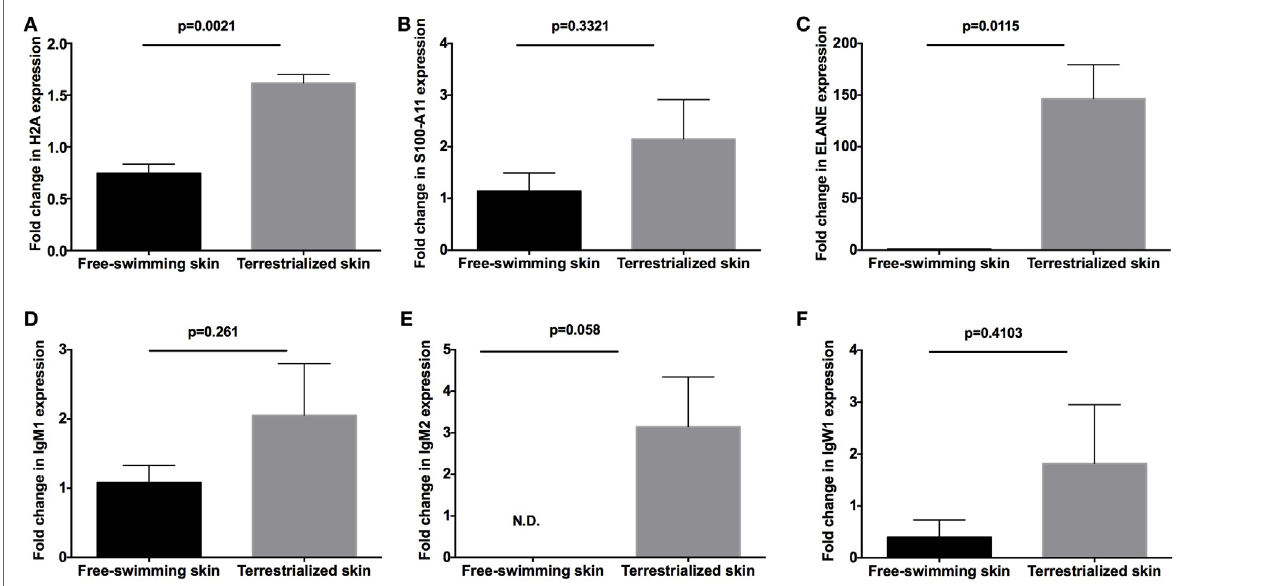
FigUre 6 | Quantitative real-time PCR analysis of the expression of (a) H2A, (b) S100-A11, (c) neutrophil elastase (ELANE), (D) IgM1, (e) IgM2, and (F) IgW1 in free-swimming and terrestrialized Protopterus dolloi skin tissue (N = 3). p -Values were calculated by unpaired t